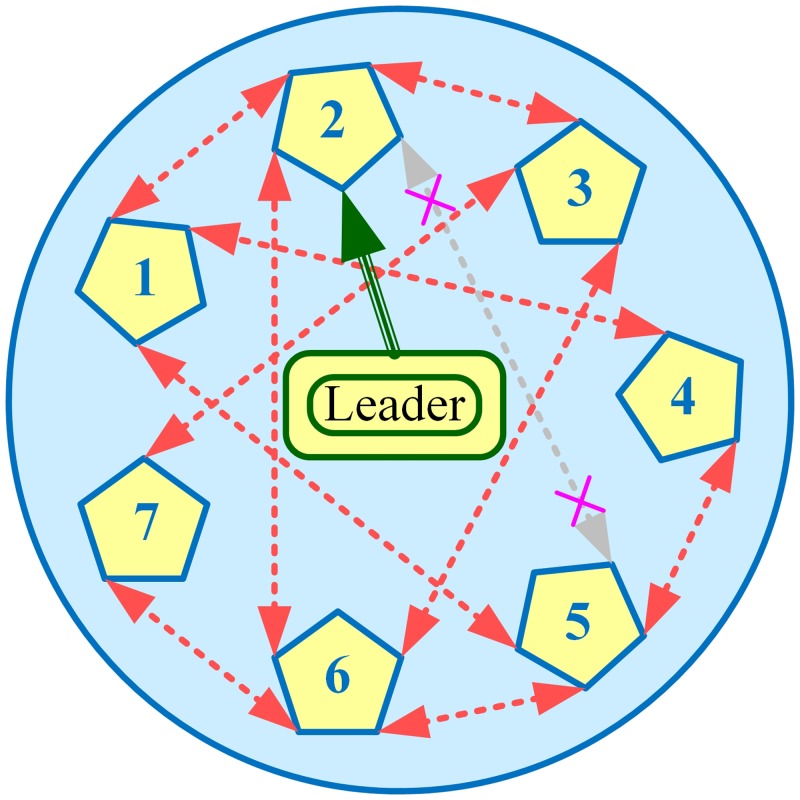
Communication graph when communication link between BESS2 and BESS5 fails.